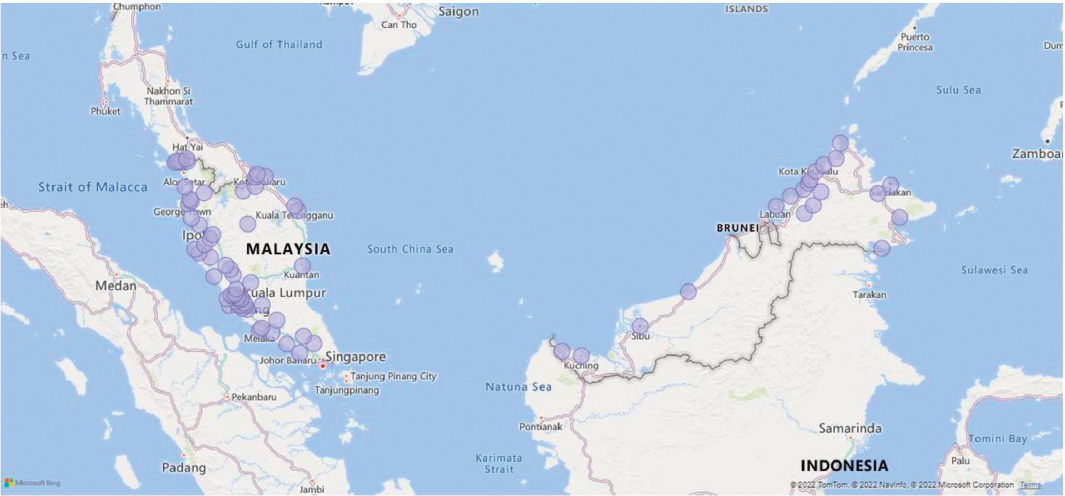
Figure 1: Distribution of the respondents in Malaysia. Table 1: Respondent’s